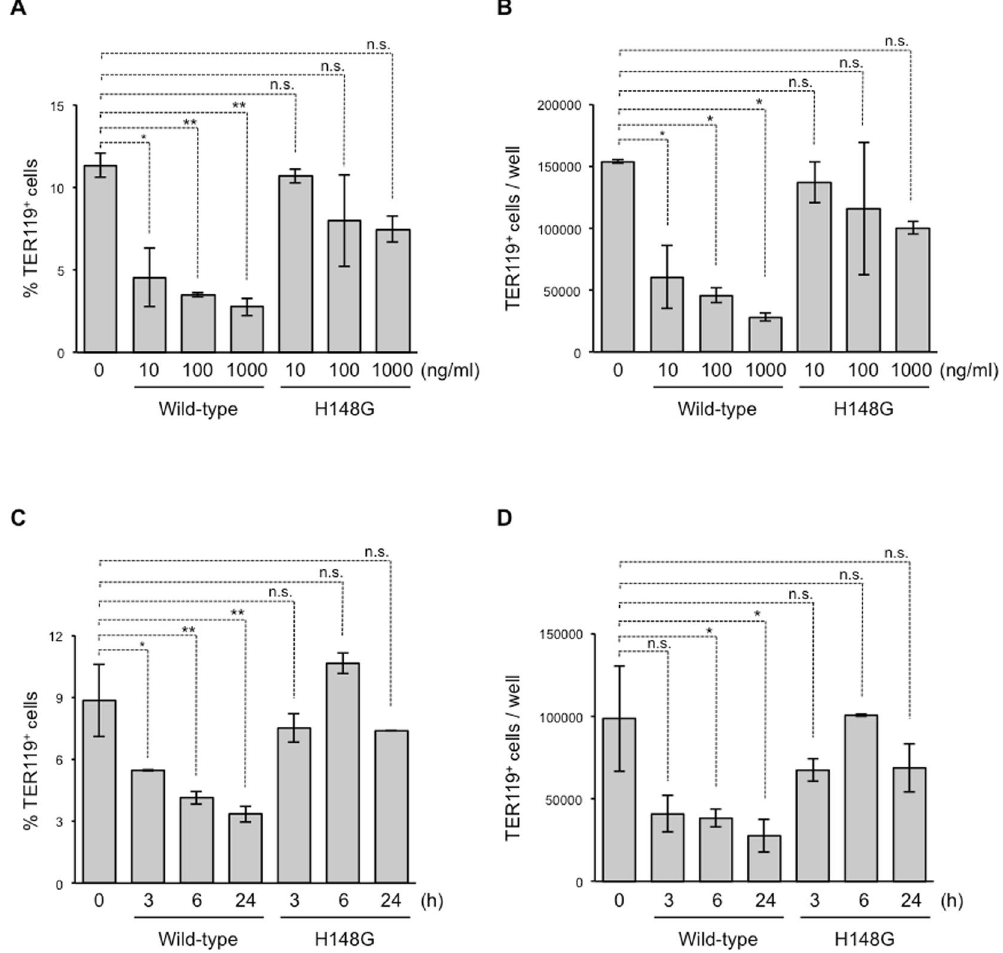
Figure 1. Treatment of bone marrow cells with α -toxin decreases TER119 + erythroblasts. Bone marrow cells were isolated from mice, and flow cytometry analysis was performed using a Guava easyCyte. ( A , B ) A total of 5 × 10 6 bone marrow cells were cultured for 24 hours in the presence of the indicated concentration of α -toxin (Wild-type) or a variant α -toxin (H148G). The frequency ( A ) and absolute number of TER119 + cells per culture well ( B ) are shown. ( C , D ) Bone marrow cells were cultured for 3, 6, or 24 hours in the presence of 10 ng/ml α -toxin (Wild-type) or a variant α -toxin (H148G), and the frequency ( C ) and absolute number of TER119 + cells per culture well ( D ) are shown. One-way ANOVA was employed to assess statistical significance. Values are mean ± standard deviation. * P < 0.05; ** P < 0.01; n.s., not